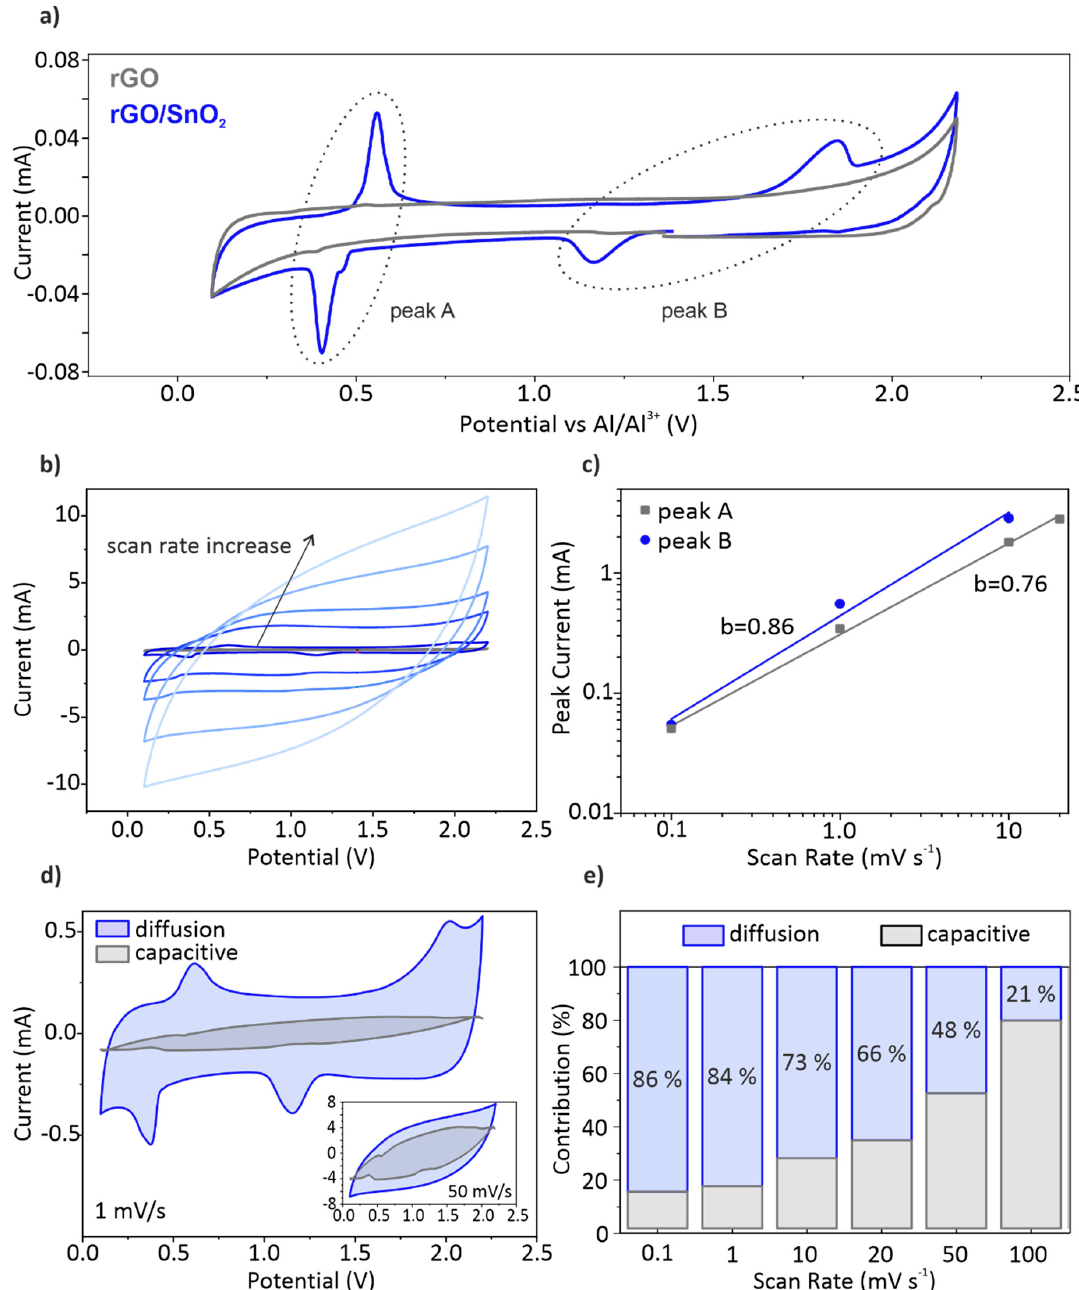
Figure 5. ( a ) Cyclic voltammograms (CV) of the rGO / SnO 2 hybrid electrode in comparison with the pristine rGO electrode at 0.1 mV s − 1 (2nd cycle). ( b ) CVs at 0.1, 1, 10, 20, 50 and 100 mV s − 1 for the rGO / SnO 2 hybrid electrode (2nd cycle). ( c ) Plot of the anodic peak current at the di ff erent scanning rates for b-value determination of peak A and peak B. ( d ) The contribution of the di ff usion and capacitive controlled current response at 1 mV s − 1 and 50 mV s − 1 (inset). ( e ) The Faradaic and non-Faradaic contribution to the whole capacity (capacitive vs. di ff usion-controlled energy storage) of the rGO / SnO 2 composite for all scanning rates, ranging from 0.1 mV s − 1 up to 100 mV s − 1 . To distinguish the contribution of the di ff usion-controlled processes to the overall energy storage from that of the pseudo-capacitive e ff ect, CV measurements with scan rates ranging from 0.1 mV s − 1 up to 100 mV s − 1 were conducted (Figure 5b). At scan rates, up to 10 mV s − 1 , the current peaks shift with a noticeable increase in peak separation. Upon increasing the scan rate to 100 mV s − 1 ,